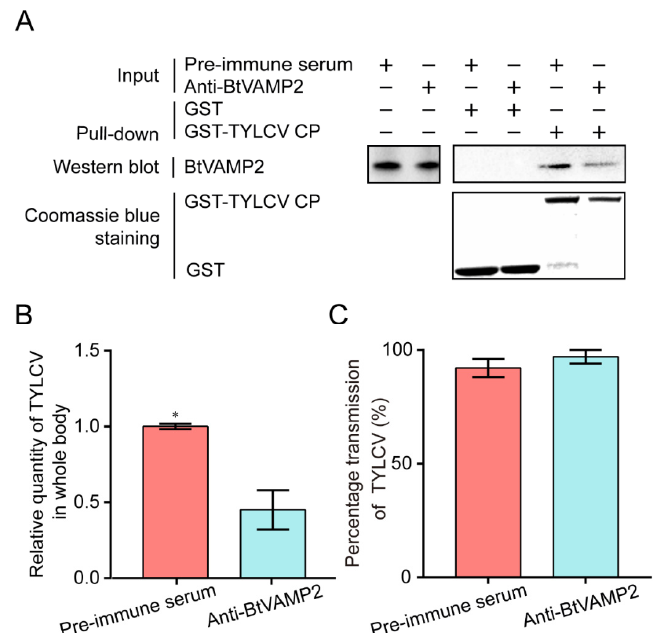
Figure 4. Analyses of the virus quantity in whitefly and the transmission efficiency of TYLCV by whiteflies after feeding with anti-BtVAMP2 pAb. ( A ) GST pull-down analysis shows that the inter- action between TYLCV CP and BtVAMP2 was reduced after feeding with anti-BtVAMP2 pAb. ( B ) The TYLCV quantity was detected by qPCR after a 24 h antibody feeding and 48 h virus acquisition ( n = 3). ( C ) Four whiteflies (female/male = 1:1) were collected and their virus transmission ability was measured (independent t -test for ( B , C ), n = 3, * p < 0.05).